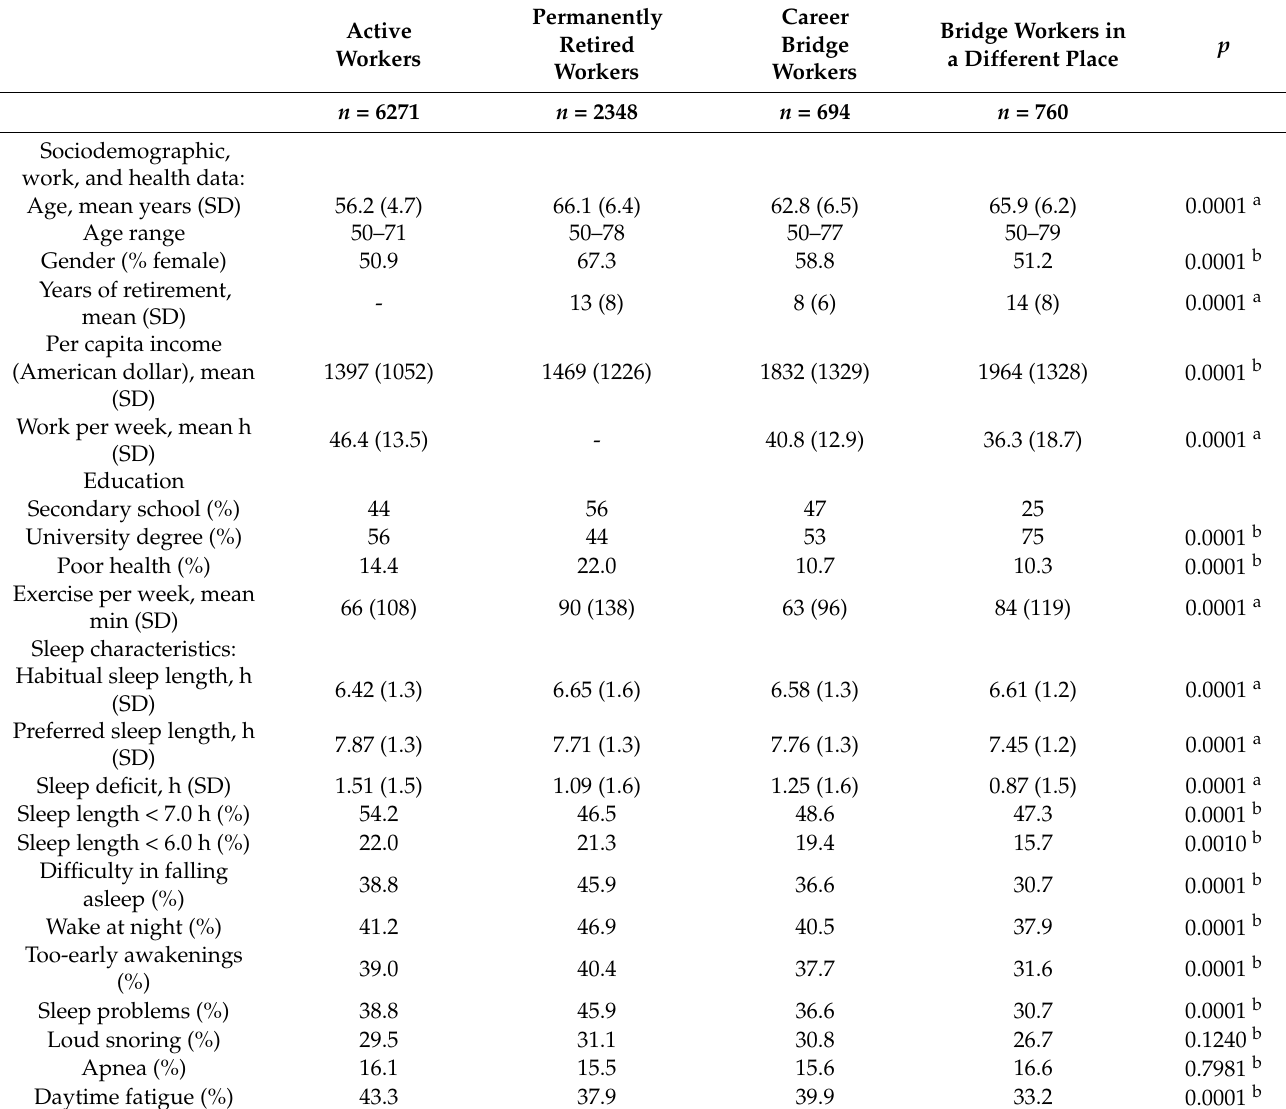
Table 1. Sociodemographic, work, and sleep characteristics of retirement groups. Longitudinal Study of Adult Health (2012–2014).